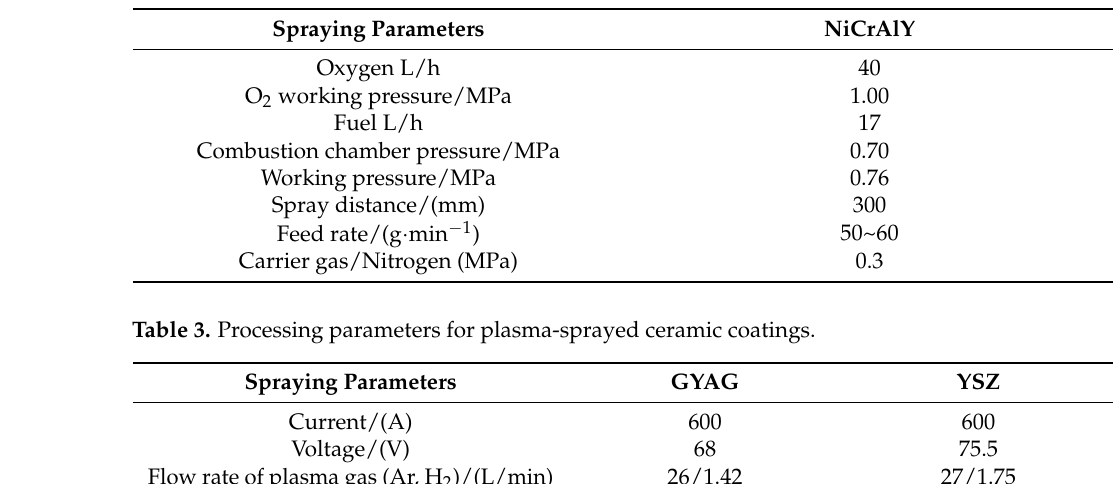
Table 2. Processing parameters for HVOF NiCrAlY bond coating.